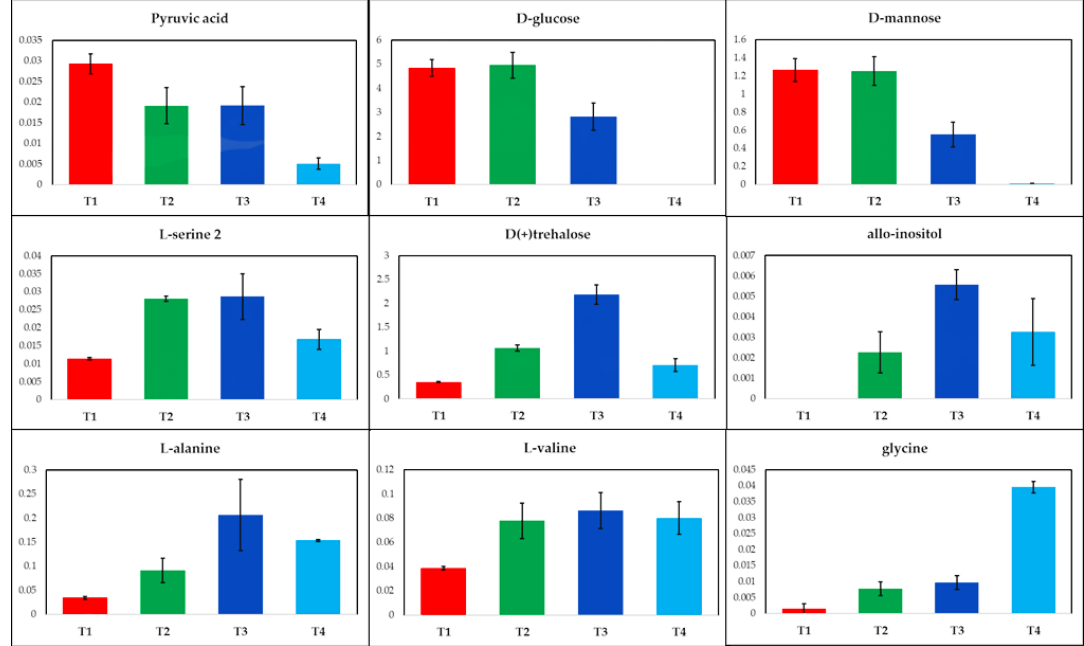
Figure 4. Relative peak areas of the significant metabolites identified by PCA of the GC-MS data acquired from the cell extracts analyzed within the Leuven laboratories. Di ff erent colors indicate the various timepoints, T1 (22 h, red), T2 (23.5 h, green), T3 (28 h, blue), and T4 (35 h,